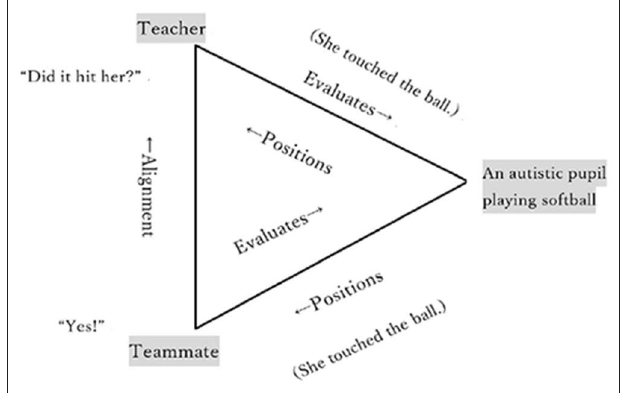
FIGURE 2 | Stance-taking triangle applied to Ochs’ observation (Ochs,